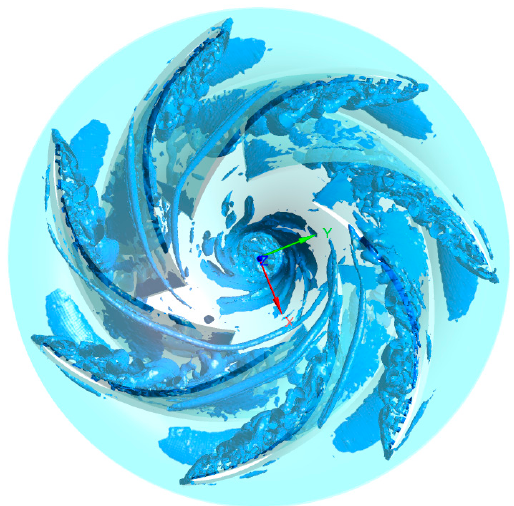
Figure 3. Velocity diagram of the Z = 0 at 100%Pn. Figure 3 . Velocity diagram of the Z = 0 at 100%Pn. Figure 3 . Velocity diagram of the Z = 0 at 100%Pn.